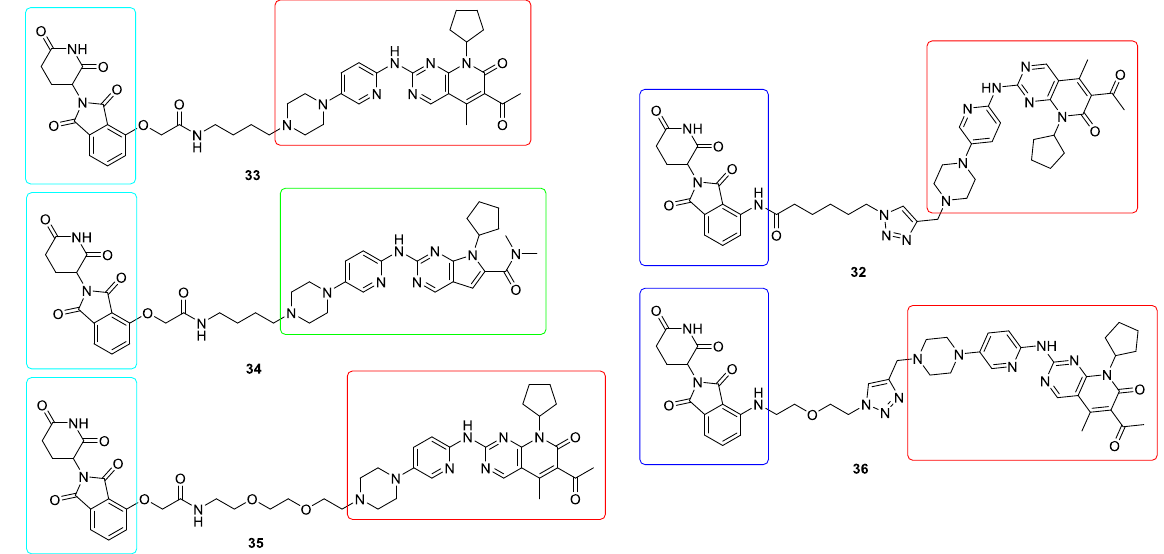
Figure 9. Chemical structures of CDK4/6 PROteolysis TArgeting Chimeras (PROTACs). Red rectangle denotes the palbociclib moiety, green rectangle denotes the ribociclib moiety, light blue rectangle denotes the thalidomide moiety and dark blue rectangle denotes the pomalidomide moiety.